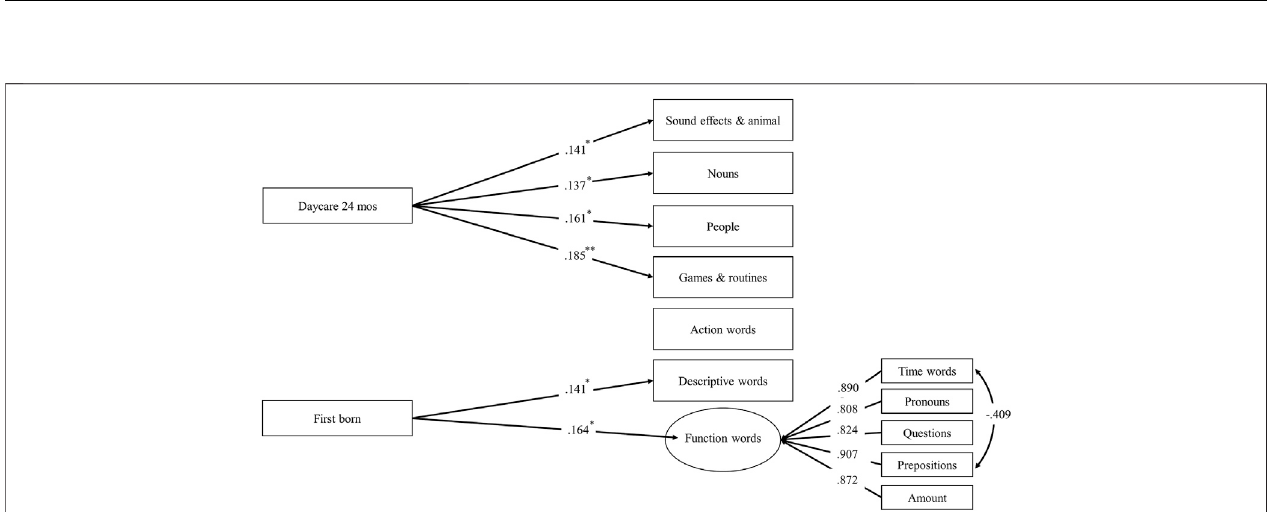
Frontiers in Communication |